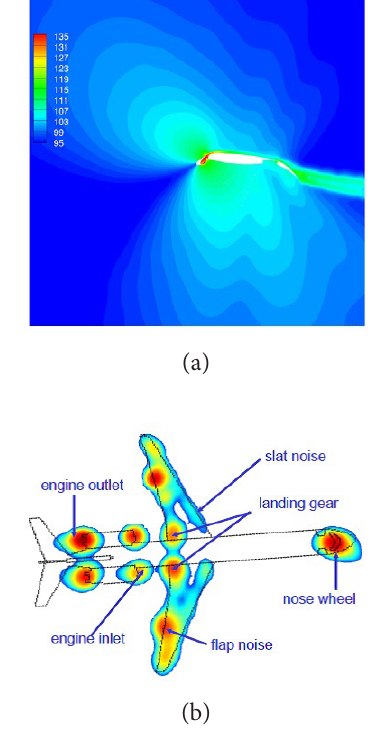
Figure 6. Illustration of noise radiation (a) from 30P-30N multi element airfoil computed using CFD method (Lockhard & Choudhari, 2009) (b) measured from different sources on aircraft using microphone array method (Oerlemans, 2009)